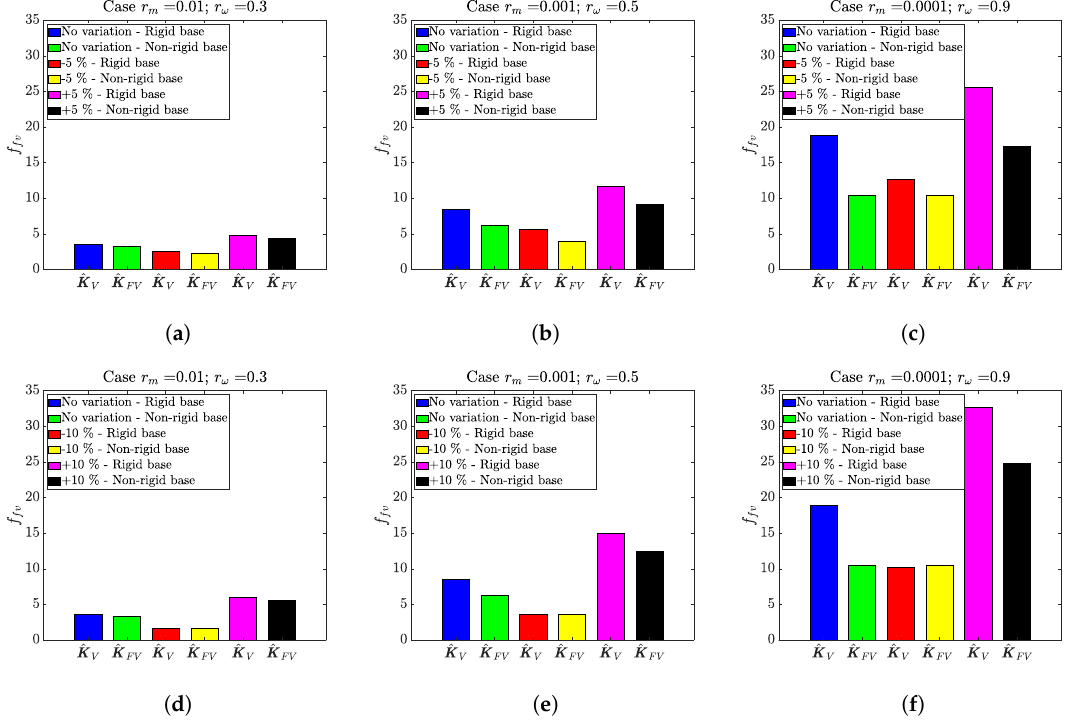
Figure 11. Effect on the VI and alignment performance due to 5% ( a – c ) and 10% variation ( d – f ) in system parameters ζ p , ω p of the mid-span isolator—symmetrical 2 2